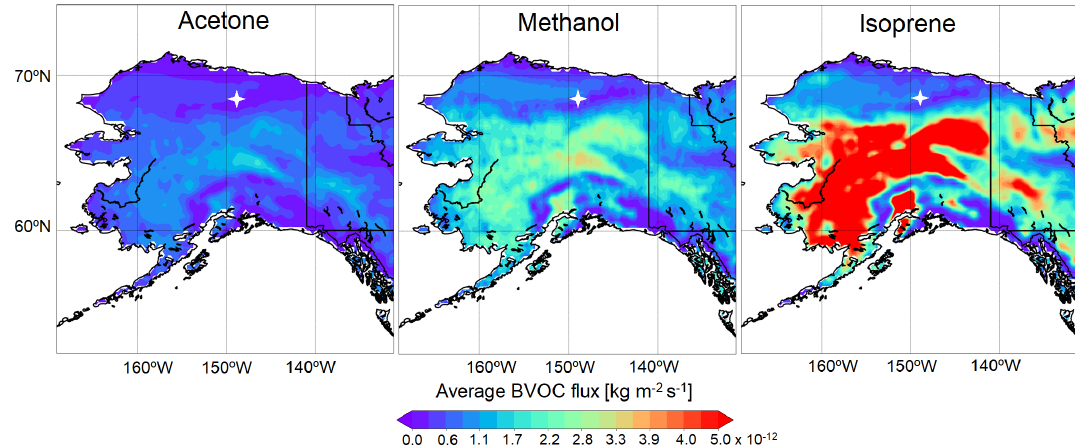
Figure 2. Monthly averaged biogenic emission estimates for acetone, methanol and isoprene over the Alaska domain in June 2019, simulated using GEOS-Chem + MEGANv2.1. The location of TFS is represented by the white marker.